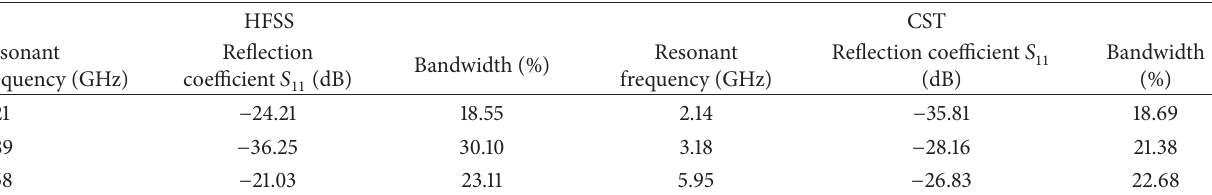
Figure 3: (a) Chromosome matrix. (b) A front view of the ground plane. Table 3: PIFA characteristics.